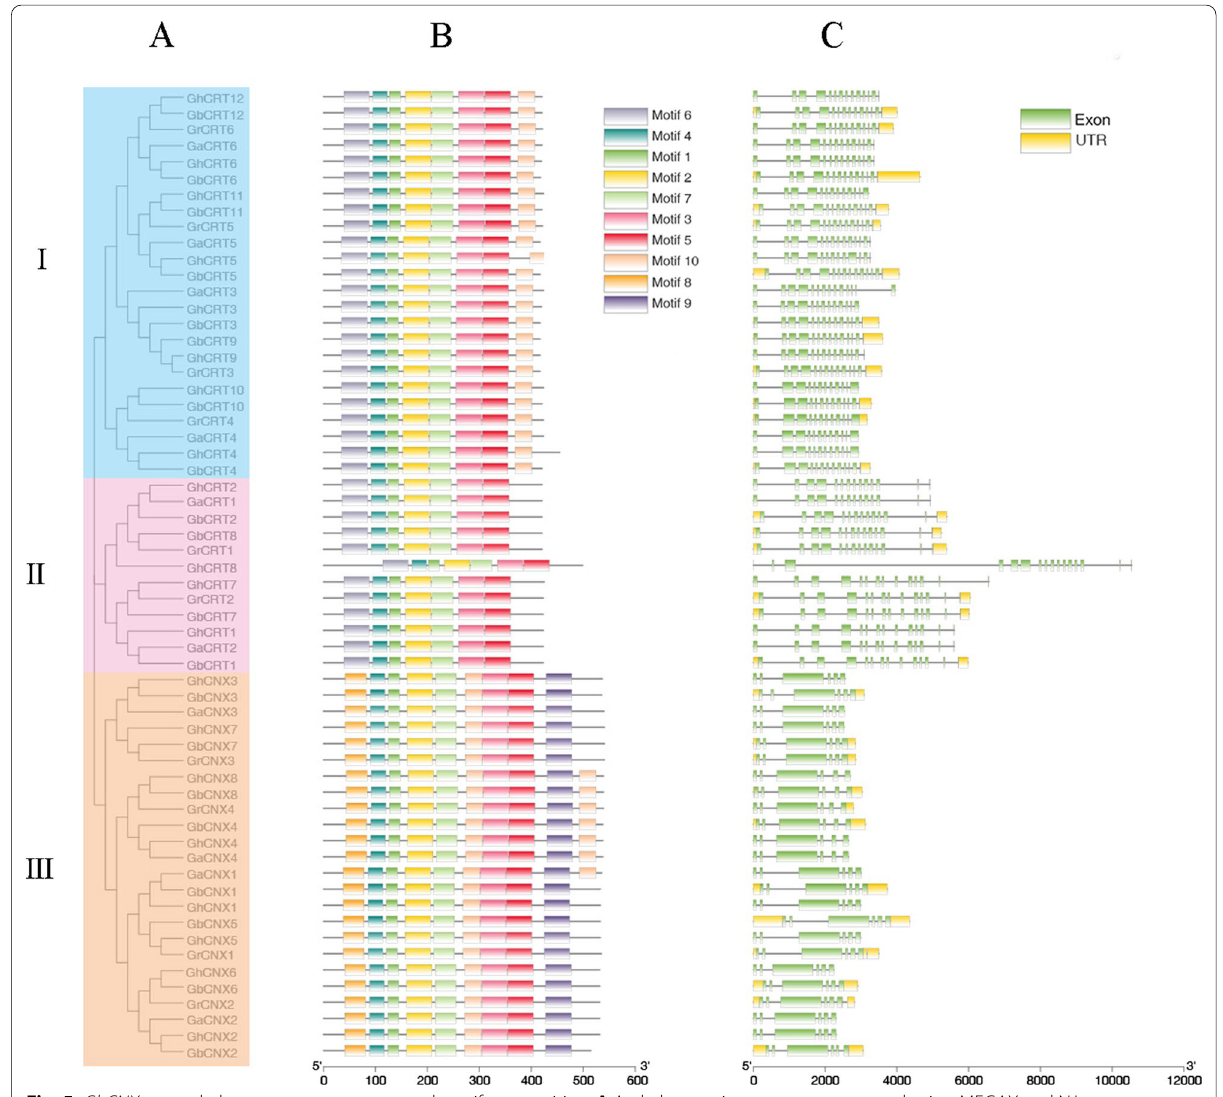
Fig. 5 GhCNX gene phylogeny, gene structure, and motif composition. A A phylogenetic tree was constructed using MEGAX and NJ (Neighbor-Joining, NJ) methods, with a number of 1 000 guided replications. B Schematic diagram of the conserved motifs in the GhCNX protein clarified by the TBtool software. Each colored box represents a motif in a protein, and its motif name is displayed in the box in the upper right corner. The length of the protein and the motif can be estimated using the ratio of the bottom. C Exon/intron organization of GhCNX gene. The green boxes represent exons, and the black lines represent